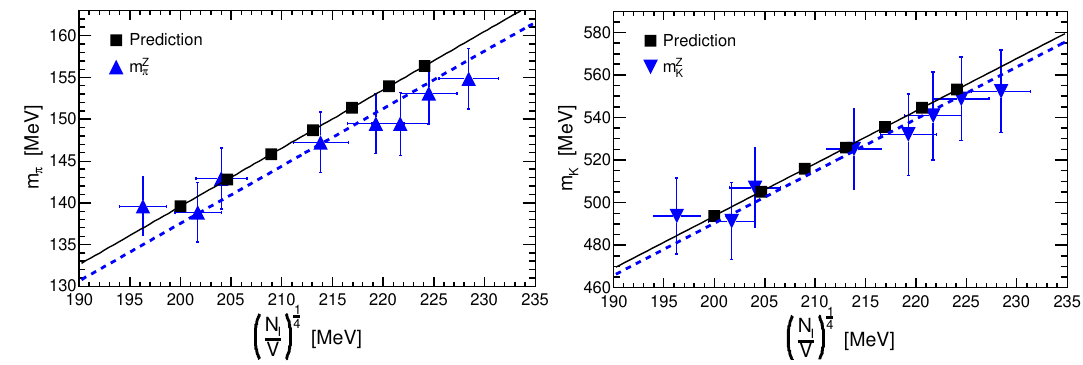
Figure 24 . Comparisons of the masses m (cid:25) (left) and m K (right) with the predictions. The black and blue lines indicate the (cid:12)tting results of the predictions and numerical results, respectively.